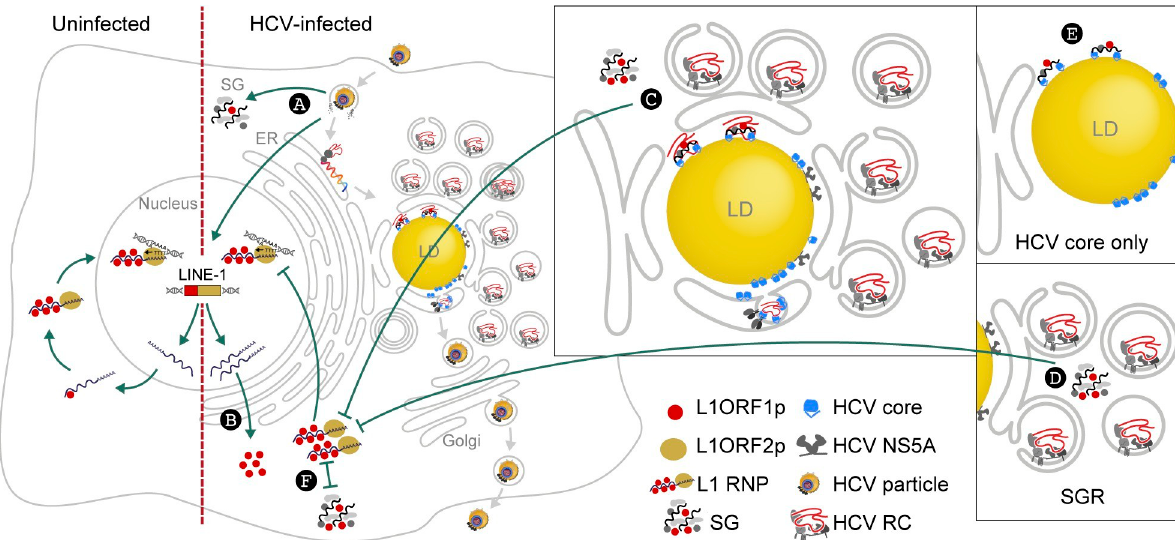
Fig 9. Model of HCV-L1 interaction and HCV-induced restriction of L1 retrotransposition. HCV infection (A) triggers stress granule (SG) formation, increases L1 expression and accumulation of L1ORF1p (B). In HCV-infected cells L1ORF1p is found in large cytoplasmic stress granules and, together with L1ORF1p-interacting proteins, is re-localized from cytoplasmic foci to lipid droplets. This re-localization depends on both HCV core trafficking to lipid droplets and the RNA-binding function of L1ORF1p. (C) Retrotransposition of engineered L1 elements is restricted in HCV- infected cells and in cells harboring HCV subgenomic replicons (SGR), which also show an increased stress granule formation (D). In contrast, ectopic expression of HCV core does not induce stress granules or impact L1 retrotransposition even though it redistributes L1ORF1p to lipid droplets (E). Thus, stress granule formation inversely correlates ( ‘a ) with L1 retrotransposition frequency, strongly suggesting that L1 RNPs are trapped within HCV-induced stress granules and not able to complete retrotransposition (F). HCV RC, HCV replication complex.